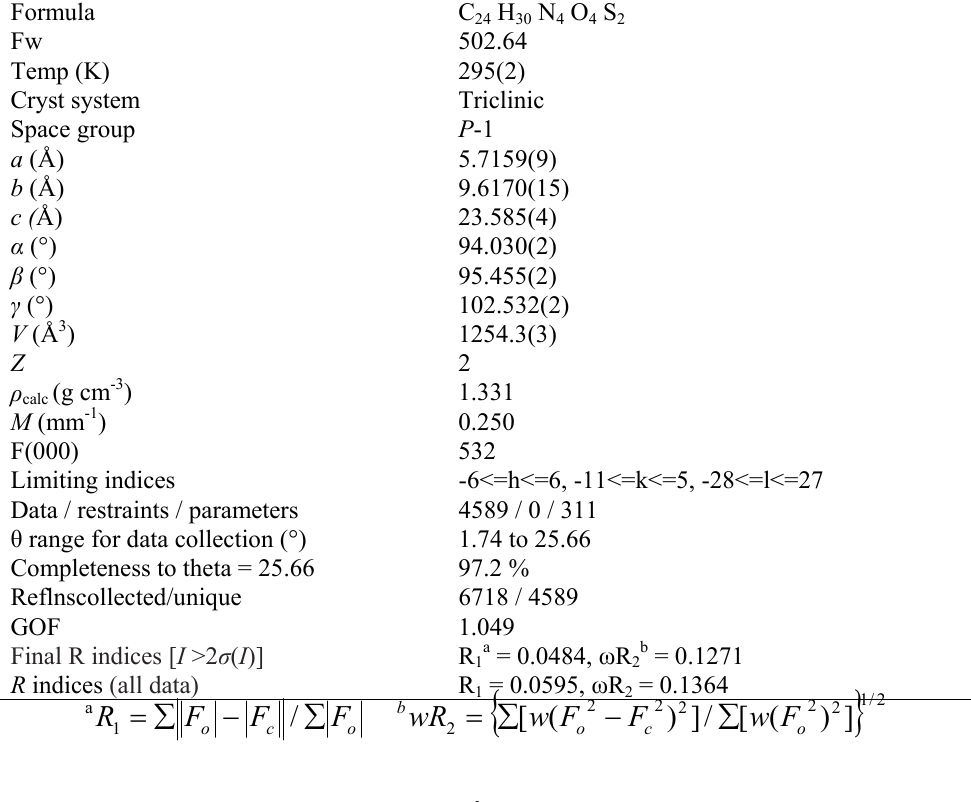
Table 2. Crystal data and structure refinement for compound 8b .